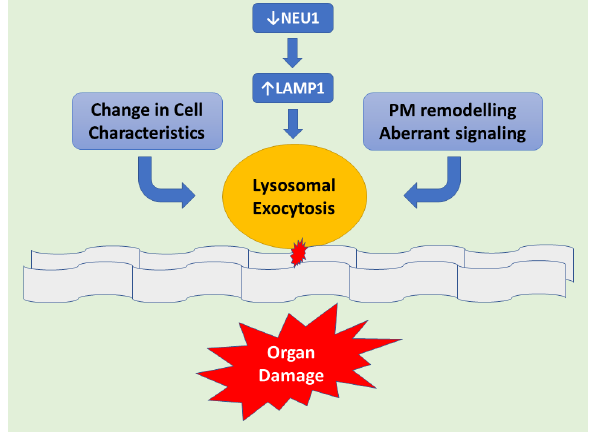
Figure 1. Schematic representation demonstrating downstream of NEU1 deficiency leads to LAMP1 accumulation causing an increased number of lysosomes at the plasmatic membrane (PM) resulting in exacerbated lysosomal exocytosis. Lysosomal-associated membrane protein 1 (LAMP1), aka lysosome-associated membrane glycoprotein 1 or CD107a, is a protein that in humans is determined by the LAMP1 gene. This abnormal release of lysosomal content causes extracellular PM remodeling. Hence changes in cell characteristics take place with subsequent organ pathogenesis.